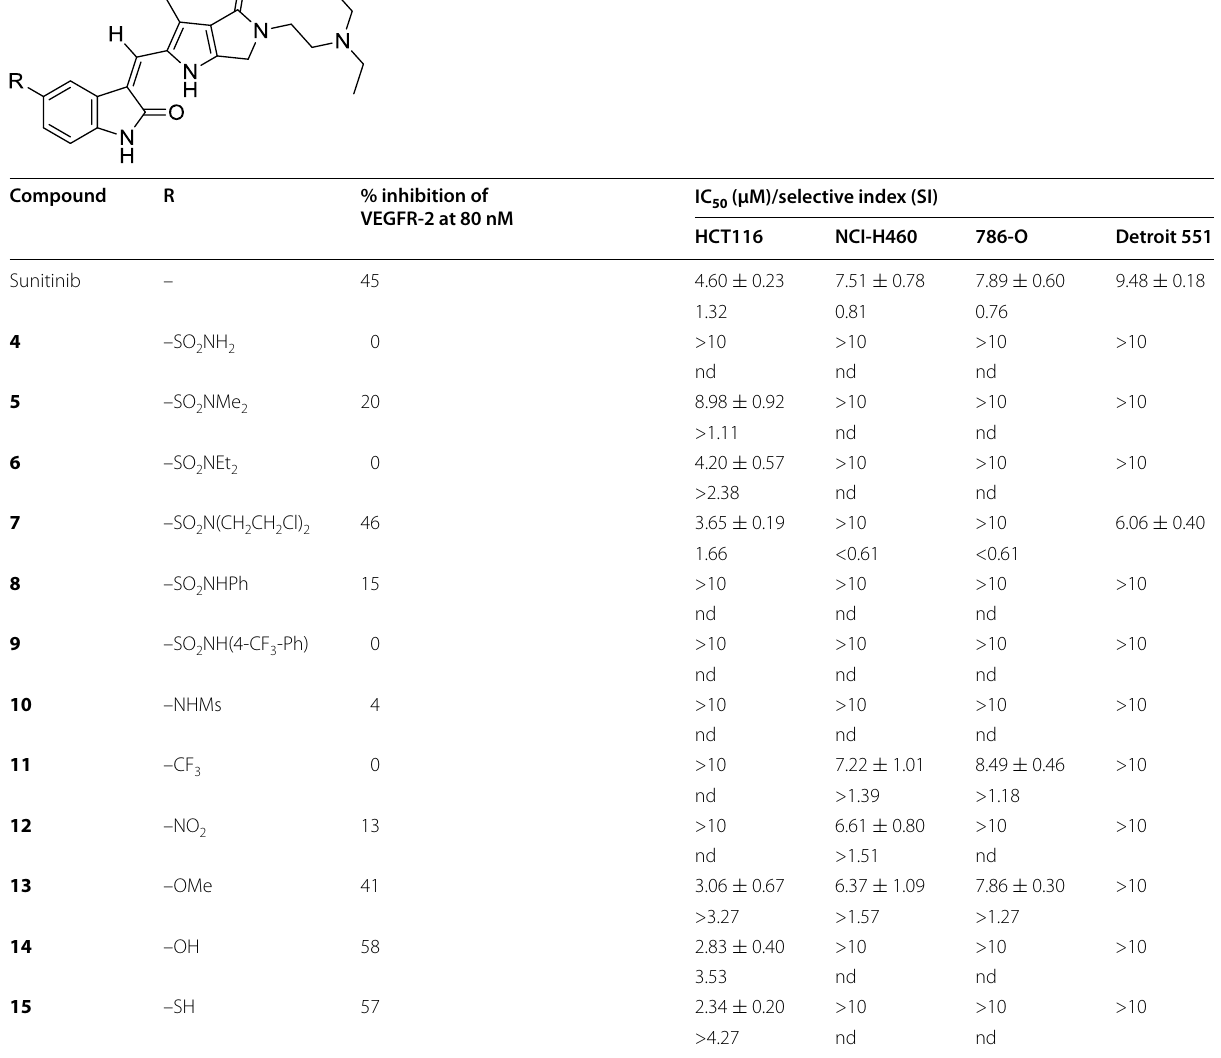
nd not detected